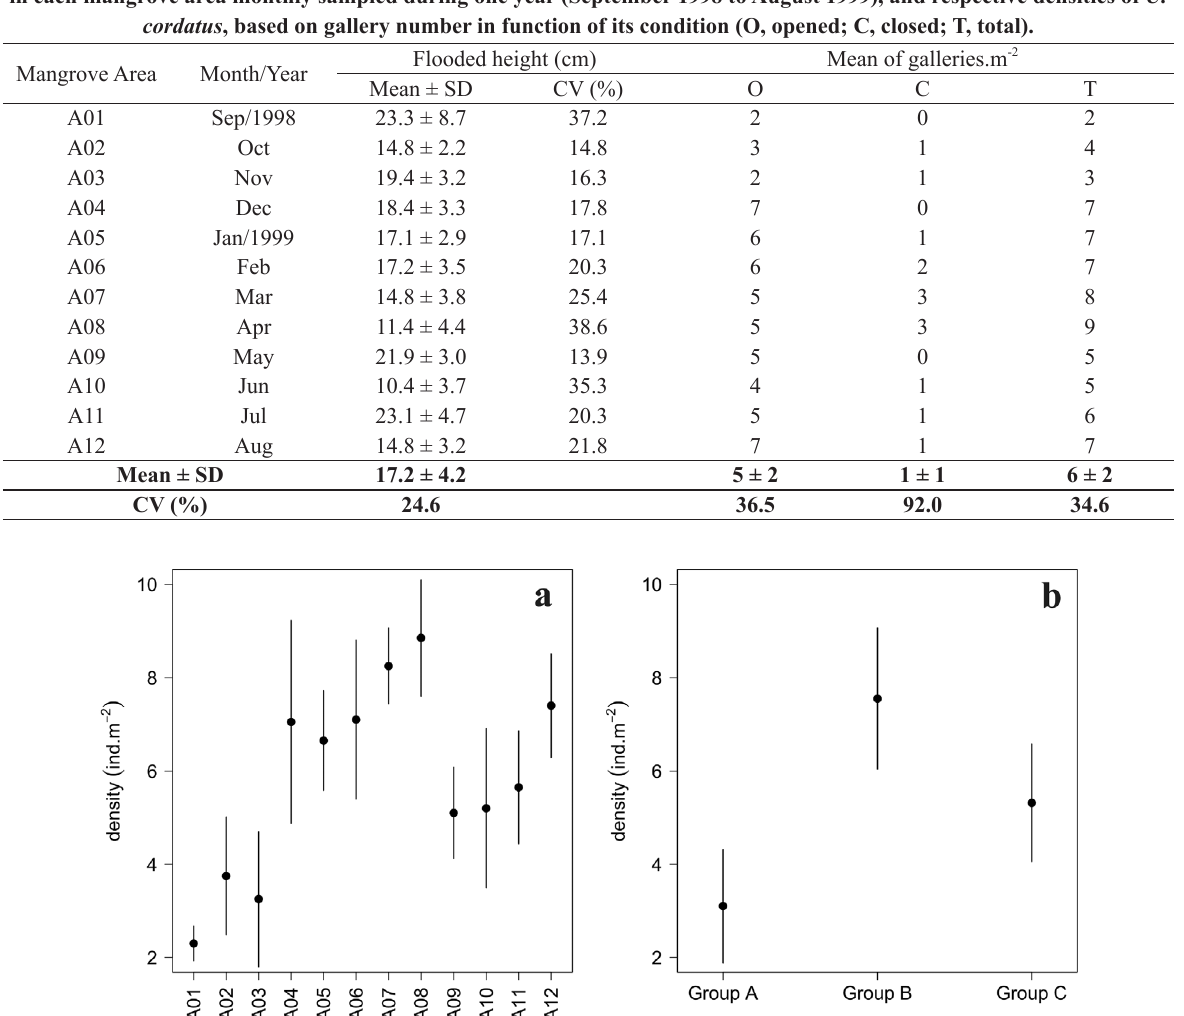
Figure 2 - Mean (± standard deviation) of Ucides cordatus density in Iguape (SP) mangroves, in each sampled area ( a ), and based on three groups ( b ) established. Where: Group A (areas A01 to A03); Group B (areas A04 to A08 and A12); and Group C (areas A09 to